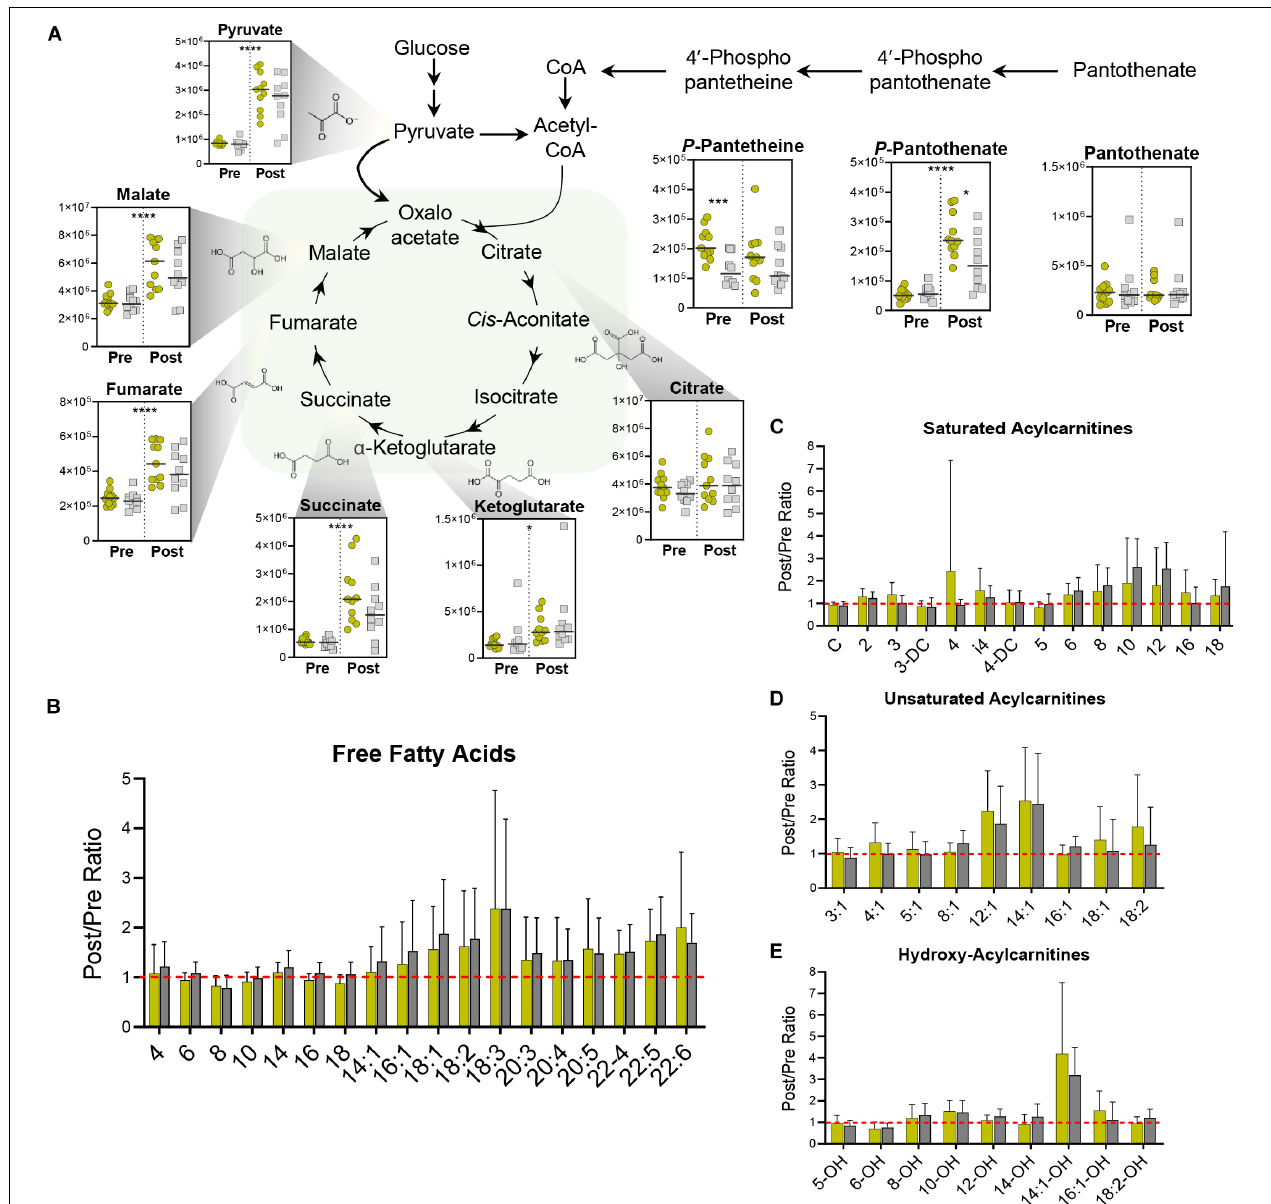
FIGURE 4 | Mitochondrial Metabolism. (A) TCA Cycle metabolite abundances [ y -axis, Peak Area (AU)] are plotted. Samples from the Gold ( ◦ ) and Silver ( (cid:3) ) groups are shown Pre and Post exercise test (divided by a dotted line). p -values from a two-tailed paired T -test of comparisons between the Pre and Post time points using combined Gold/Silver group values are shown above the dashed line. p -values from a two-tailed unpaired homoscedastic T -test comparing the Gold and Silver groups at each time point are shown on the respective side of the dashed line. Intra-subject ratios between the Post and Pre timepoints for both Gold and Silver groups are shown for (B) free fatty acids, (C) saturated acylcarnitines, (D) unsaturated acylcarnitines, and (E) hydroxy acylcarnitines. * p < 0.05; ** p < 0.01; *** p < 0.001; **** p <